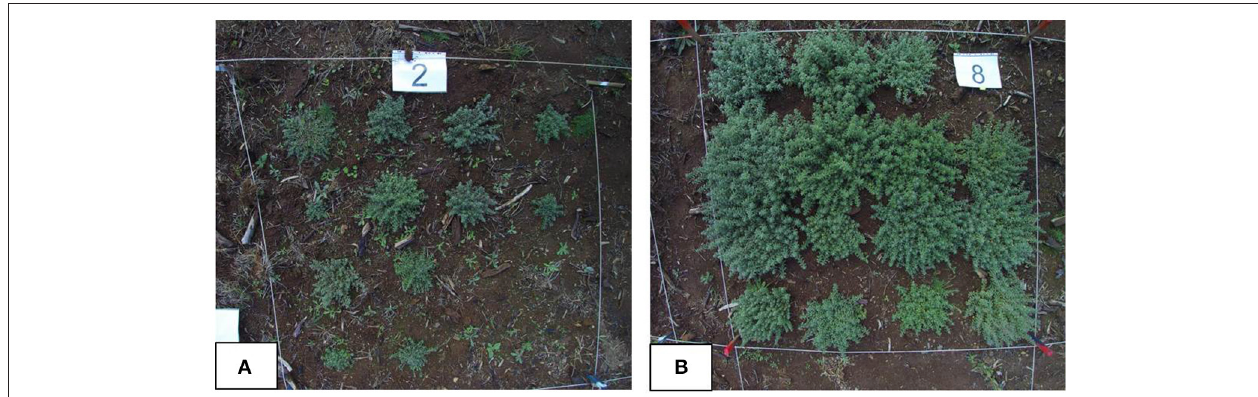
FIGURE 1 | Aerial view of field plots (4 m 2 ) with non-inoculated (A) and inoculated (B) Odontarrhena muralis s.l . Plants were inoculated with Paenarthrobacter nitroguajacolicus strain LA44 (Pardo et al.,